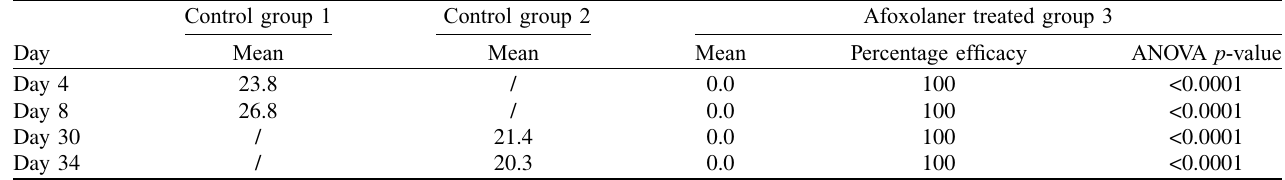
Table 3. Acaricidal ef fi cacy using arithmetic mean for Haemaphysalis elliptica